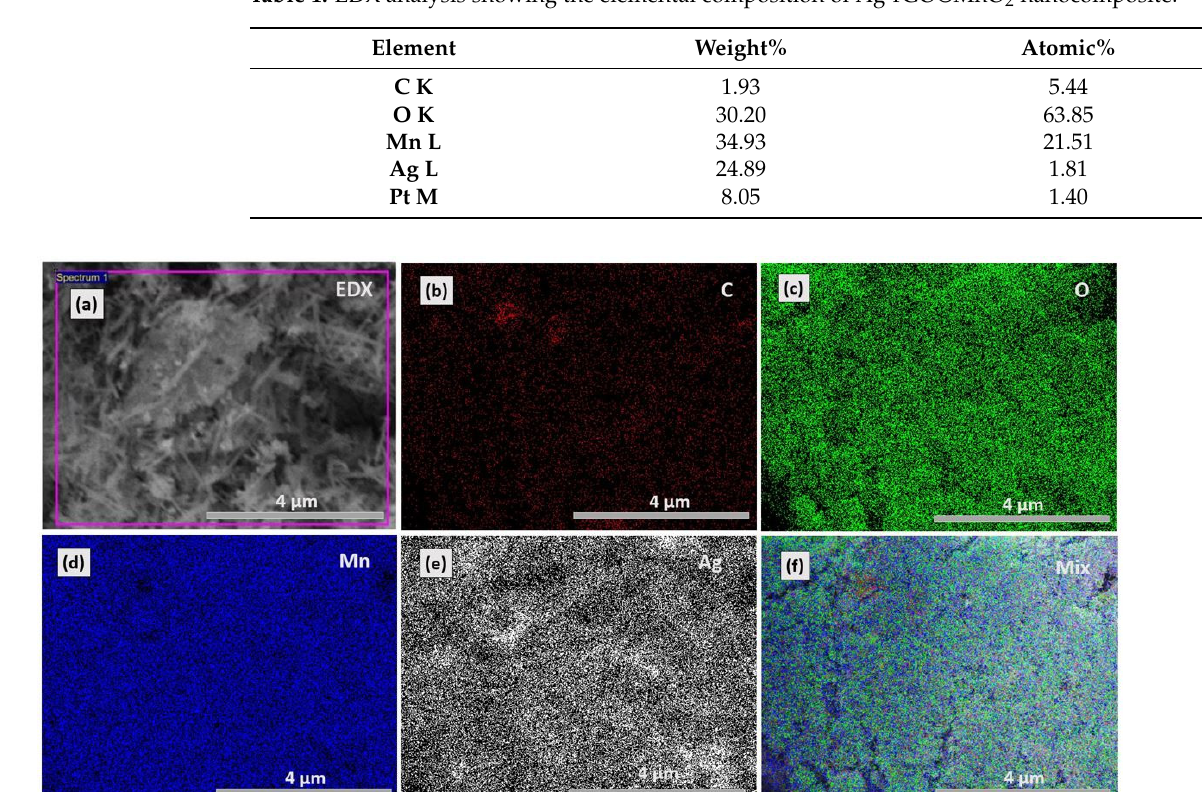
Figure 5. EDX mapping image ( a ) scan area, ( b ) C, ( c ) O, ( d ) Mn, ( e ) Ag, and ( f ) mixture of all elements in Ag-rGO@MnO 2 nanocomposite.